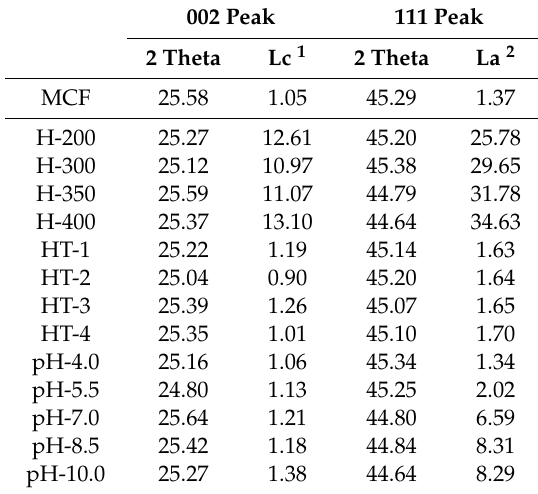
Table 2. Microcrystalline structural parameters of MCF as a function of processing